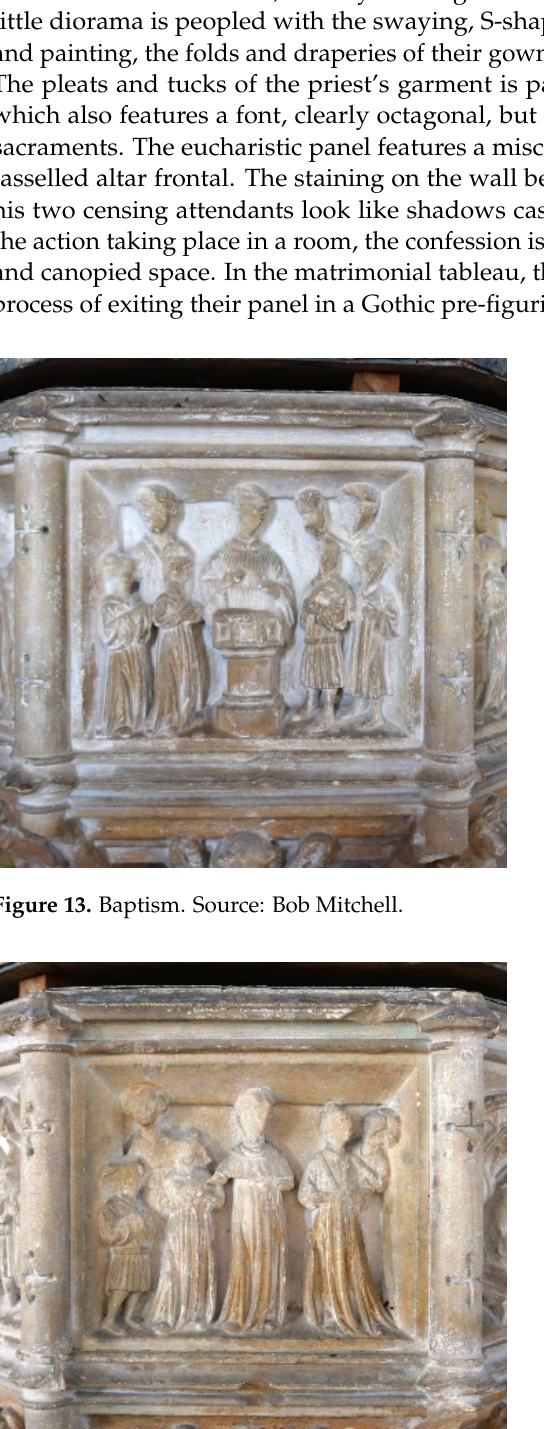
Figure 14. Confirmation. Source: Bob Mitchell.